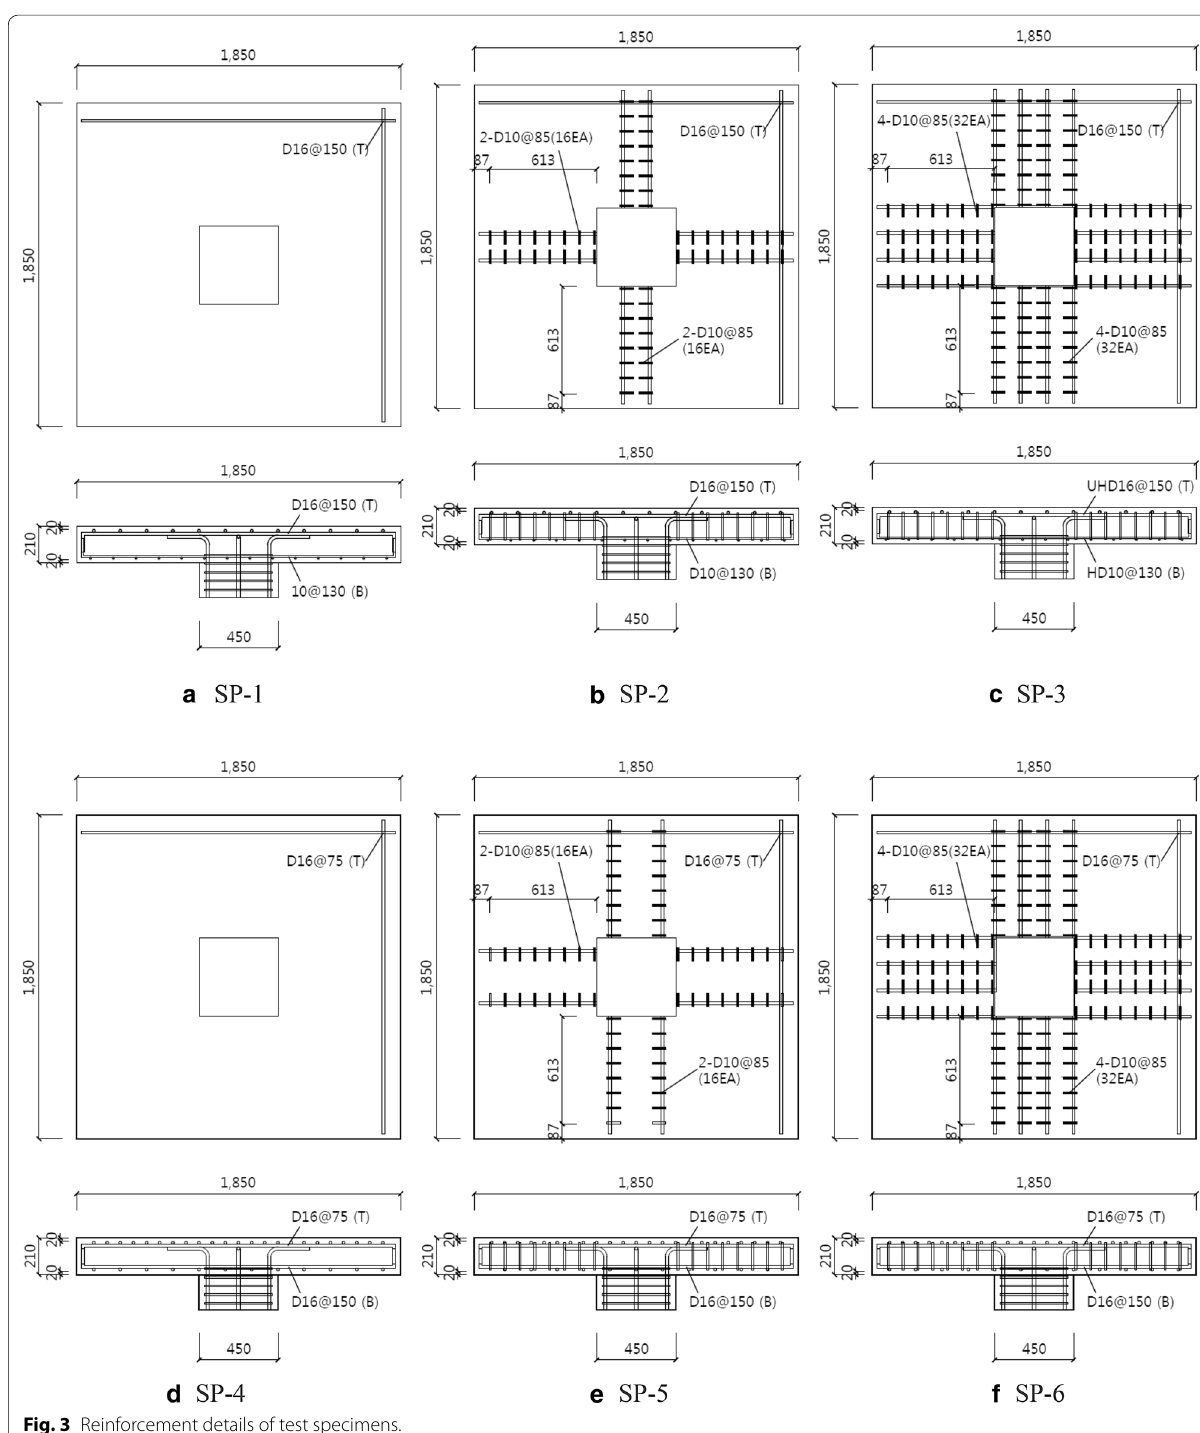
Fig. 3 Reinforcement details of test